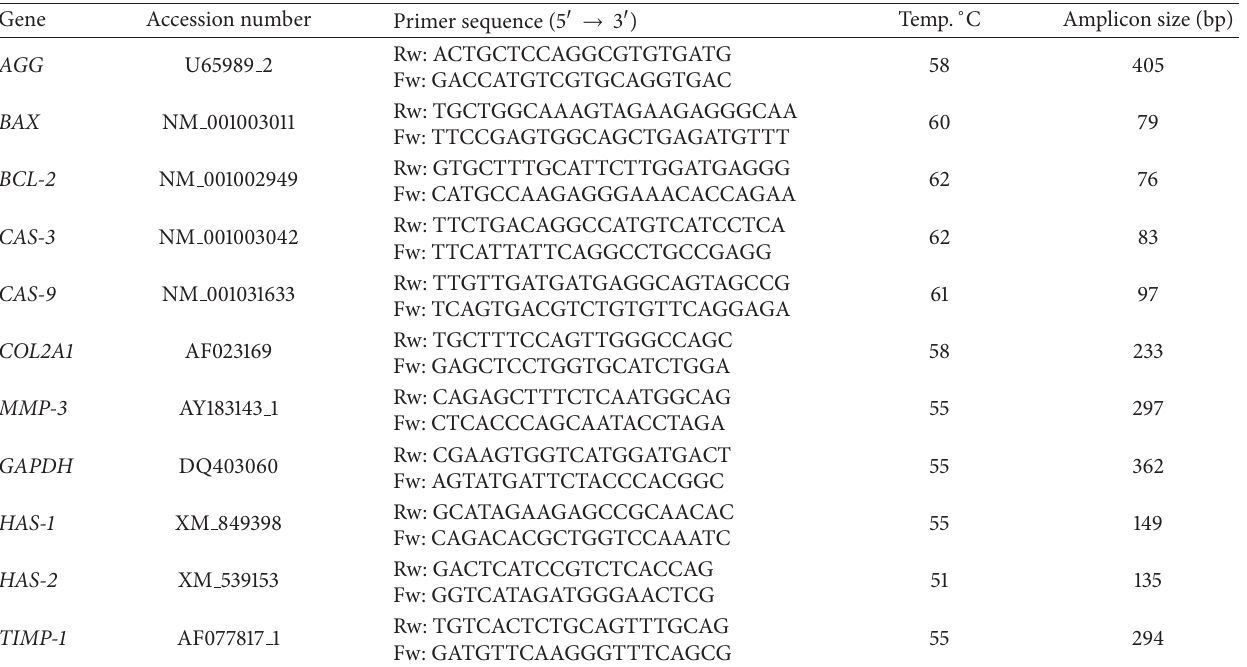
Table 1: Sequences of sense and antisense primers used for amplification in real-time